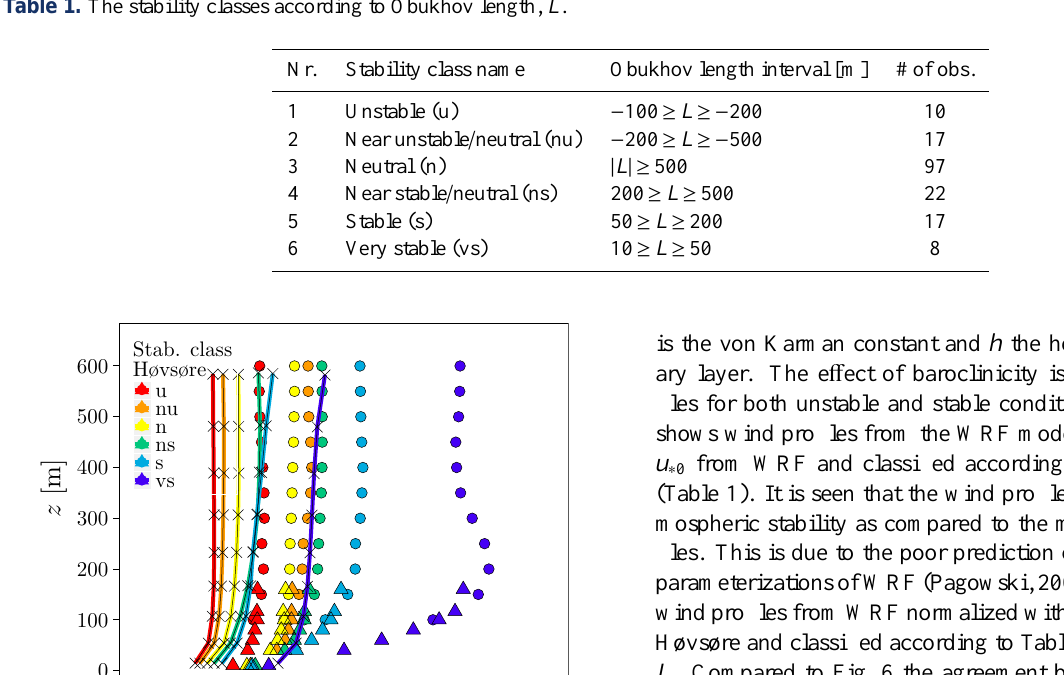
Table 1. The stability classes according to Obukhov length, L .